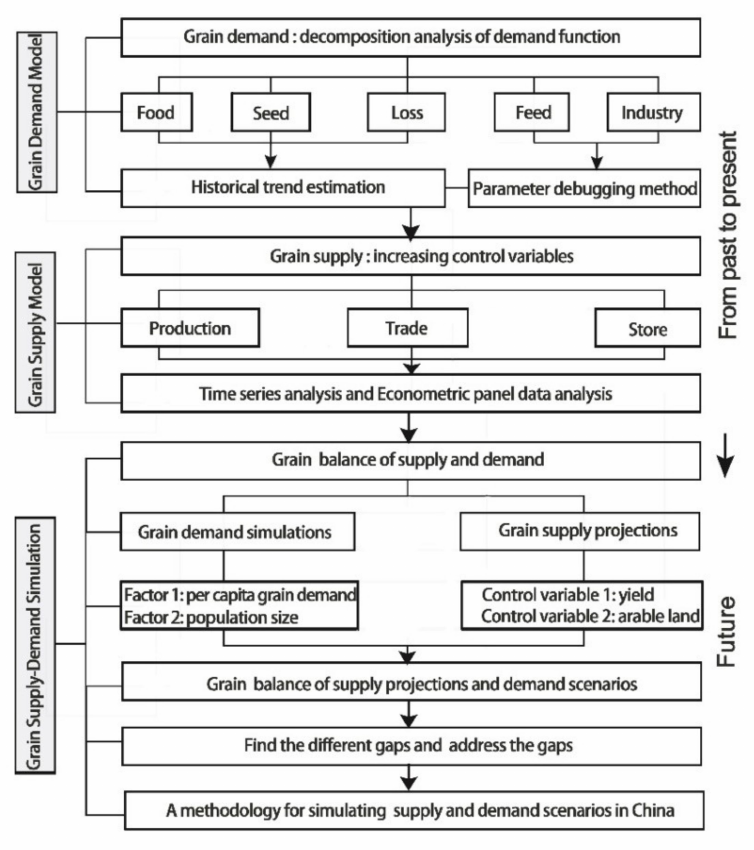
Figure 1. Research